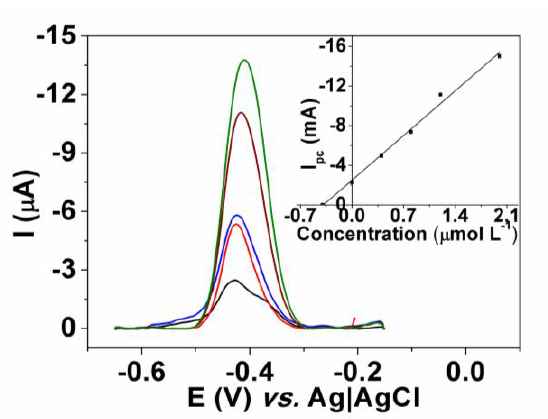
Figure 8. SWV in 0.04 mol∙L −1 B-R buffer spiked with increasing amounts of AG25. Insert: relation between I pc vs. concentration AG25. Parameters: pH 4.0, ƒ = 10 Hz and ΔE = 60 mV.